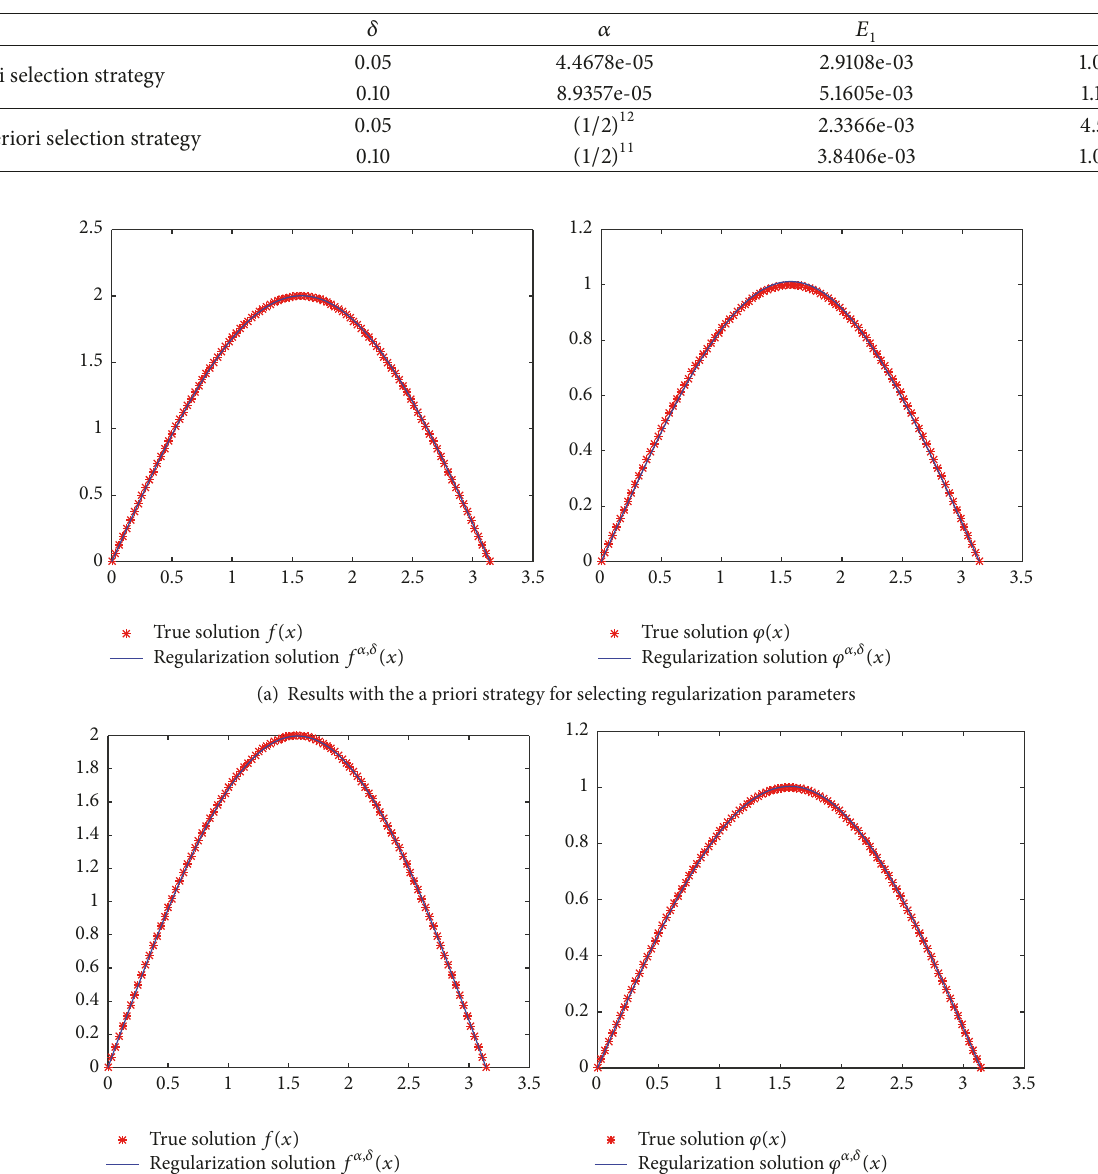
Table 1: Numerical results of Example 1.